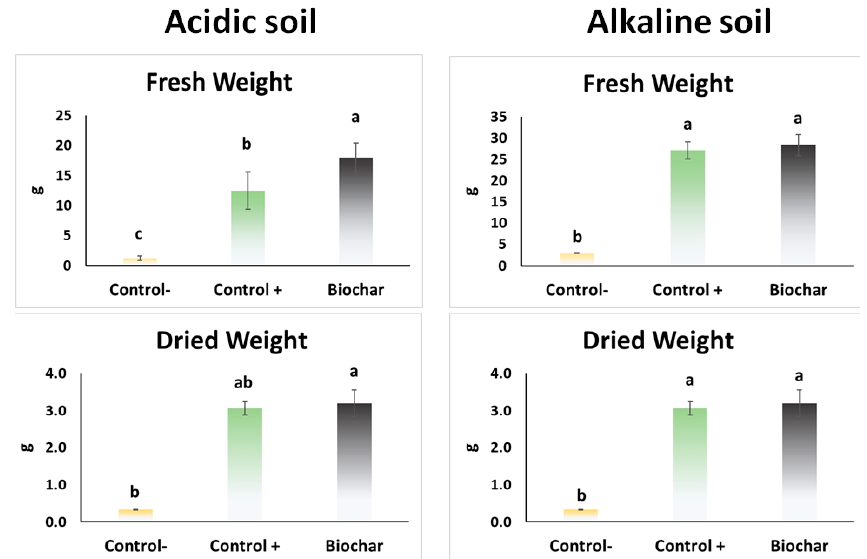
Figure 5. Tomato plants—fresh and dried weight—in both acidic and alkaline soils. Control -, without Pi; Control +, with Pi and biochar, with Pi + biochar as an amendment. Different letters indicate significant differences among treatments.